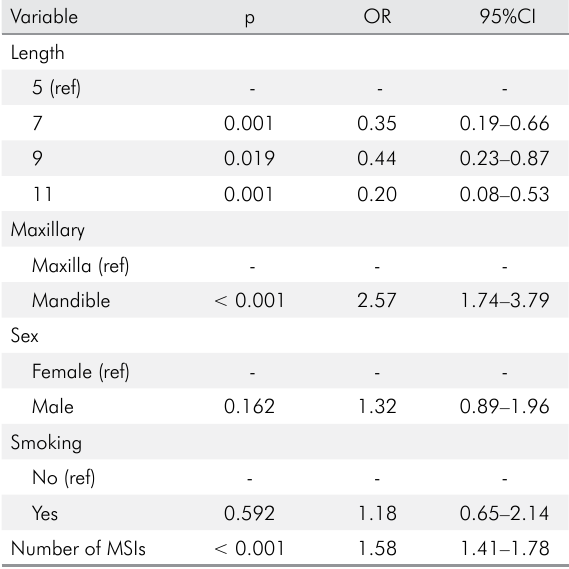
Table 11. Multilevel model analysis considering length, bone location, sex and smoking